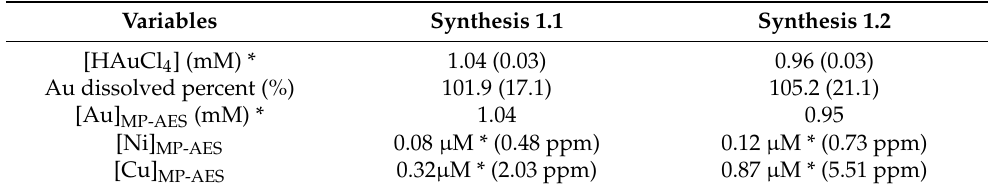
Figure 6. UV-Vis calibration curves between 310 and 320 nm. Table 4. Concentration of Au, Ni and Cu obtained by MP-AES, and concentration of HAuCl4 obtained by the calibration curve of products 1.1 and 1.2.